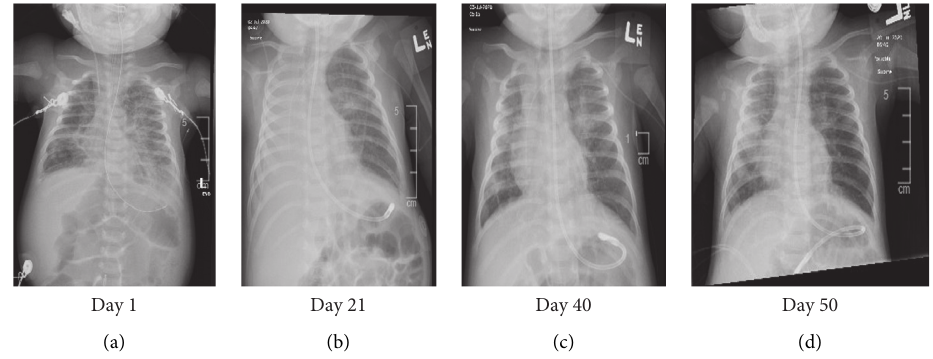
Figure 4: Radiologic trend showing progression of clinical condition from